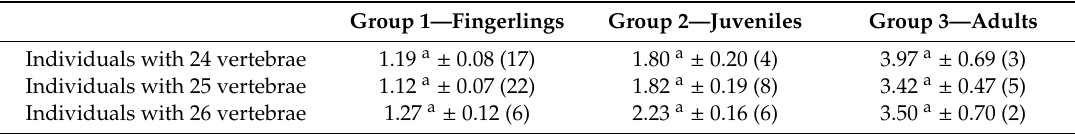
Table 3. Mean length of the 24th vertebra (mm) of European seabass individuals grouped by age and total number of